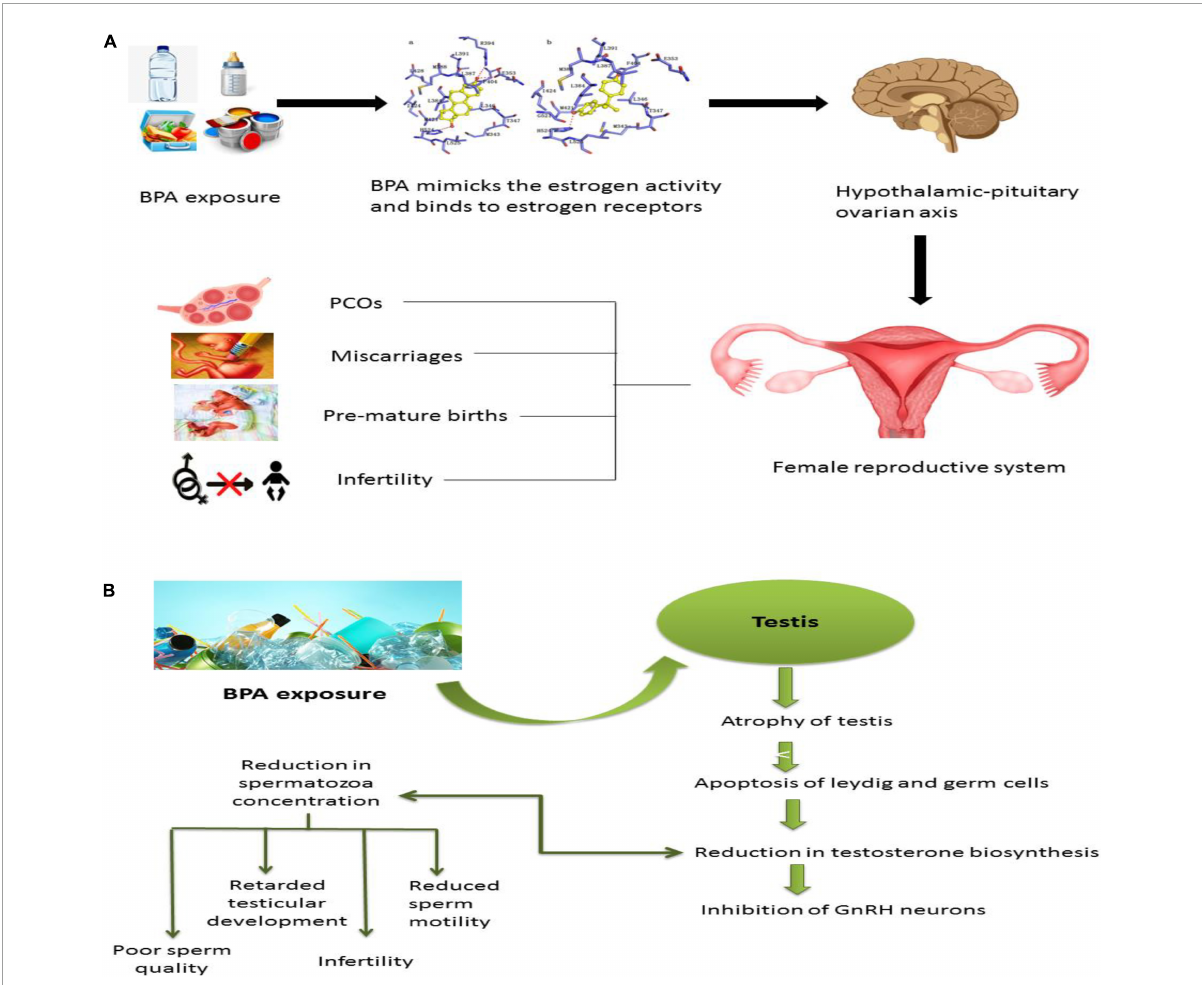
FIGURE3 Effect of BPA on the reproductive system. (A) When exposed to BPA, females can develop fertility-related issues as it is very similar to estrogen structure and function. It binds to estrogen receptors and causes irreversible alteration to the hypothalamic-pituitary-ovarian axis. BPA will provoke estrogen and thus increase the chances of PCOs, delay puberty, miscarriages, endometriosis, premature births, and most of the time, BPA can cause infertility. (B) Exposure of males to bisphenol interferes with the reproductive system. BPA causes atrophy in the testis, apoptosis in Leydig cells and germ cells, and reduction in testosterone biosynthesis, which will either cause the reduction in spermatozoa reduction or inhibition of GnRH neurons. It causes sperm quality and quantity alterations, retardation of testicular development, infertility, and reduction